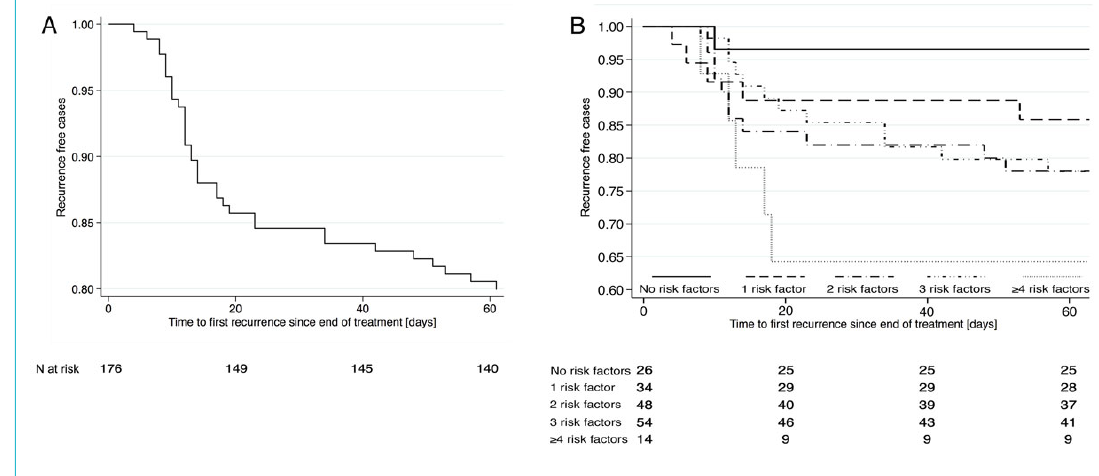
Figure 1: A: Kaplan-Meier curve showing Clostridioides difficile infection recurrence within 60 days after treatment. B: Recurrence by number of risk